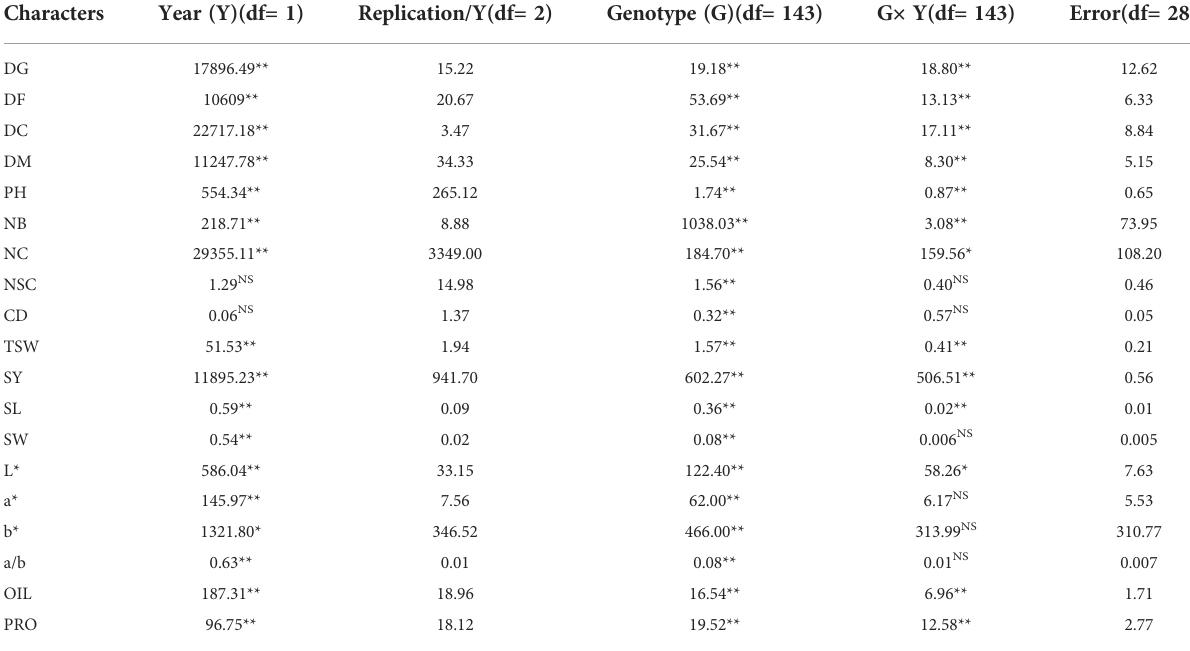
TABLE 2 Combined ANOVA for measured traits in 144 fl ax genotypes evaluated during two